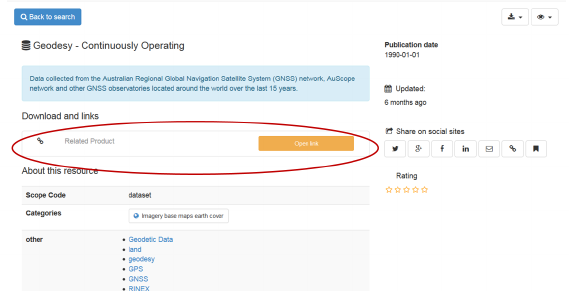
Figure 4 Landing page for human metadata consumption with link to related products to ‘Geodesy – Continuously Operating’ But again, this link takes several additional manual clicks to get to the resource as illustrated in Figure 5.